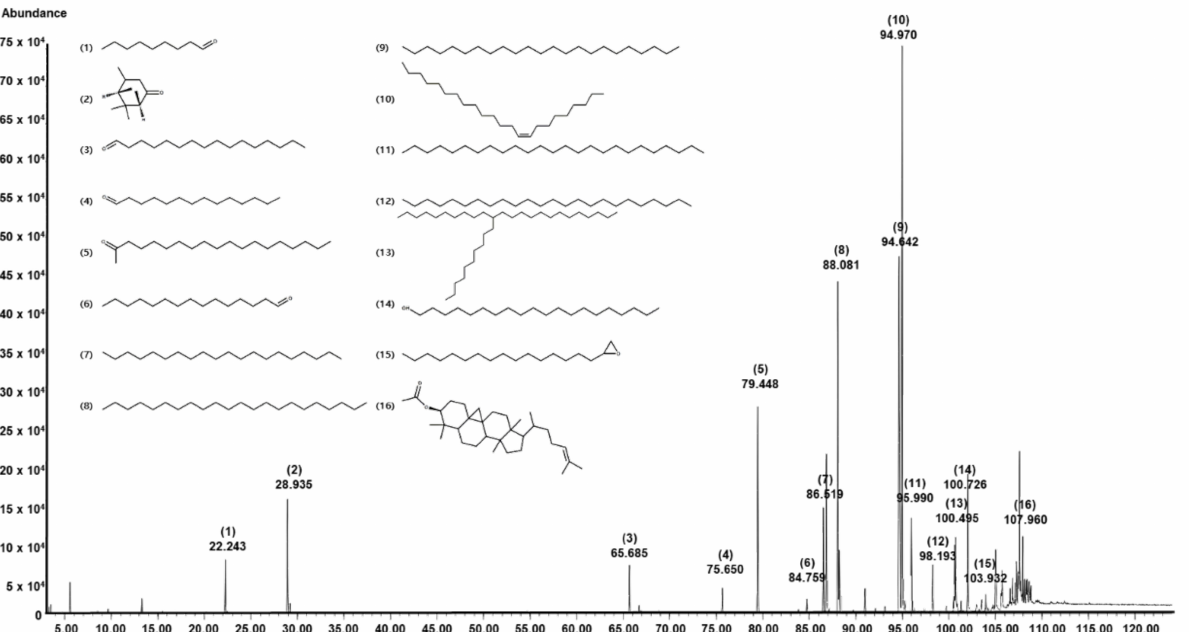
Figure 1. GC/MS total ion chromatogram of Salix koreensis Anderss flower absolute. Bracketed and unbracketed numbers at each peak express component numbers and retention times, respectively, of the 16 identified components (Table 1). Bracketed numbers and chemical structures on the upper left side of the chromatogram indicate the 16 identified